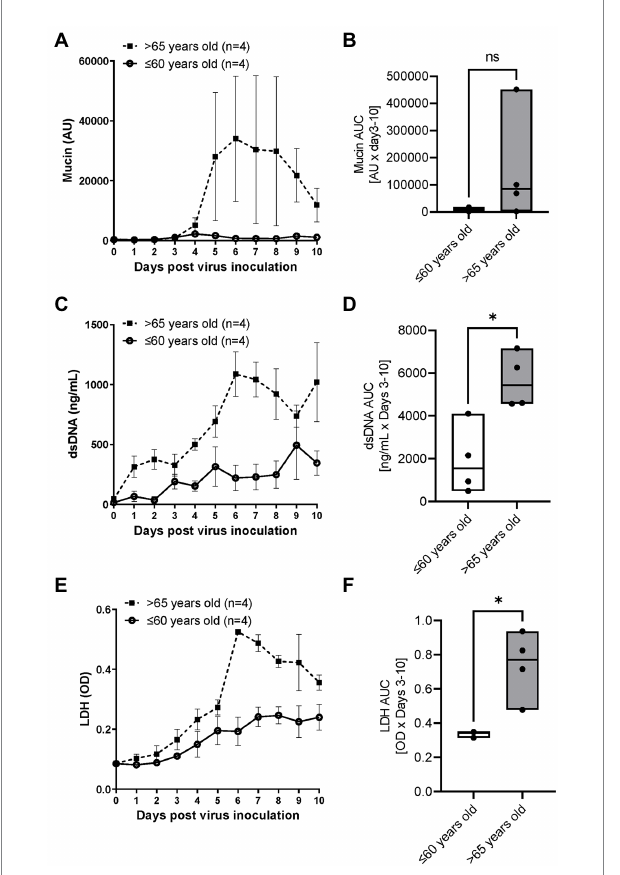
FIGURE 3 The comparison of RSV A2 induced mucin production and dsDNA/ LDH release in apical washes collected from ALI-bronchial epithelium post RSV A2 inoculation in younger ( ≤ 60 years old) and elderly (>65 years old) groups. (A) Time-profile of mucin production, (B) AUC (Day 3–10) of mucin, (C) Time-profile of dsDNA, (D) AUC (Day 3–10) of dsDNA. (E) Time-profile of LDH, and (F) AUC (Day 3–10) of LDH. Mean ± SEM, * p < 0.05. AU: absorbance units, OD: optical density, NS: not significant.